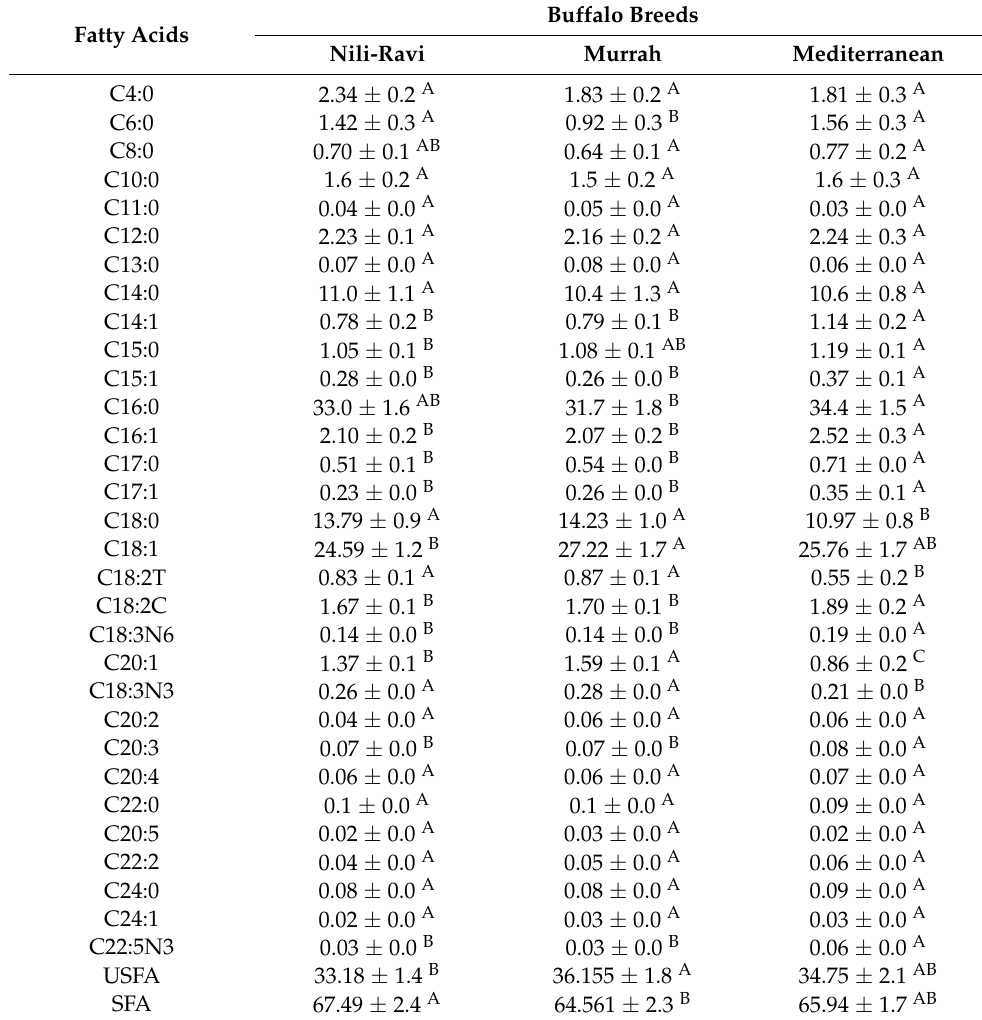
Table 2. Fatty acid (%) profile of milk from different buffalo breeds. Fatty